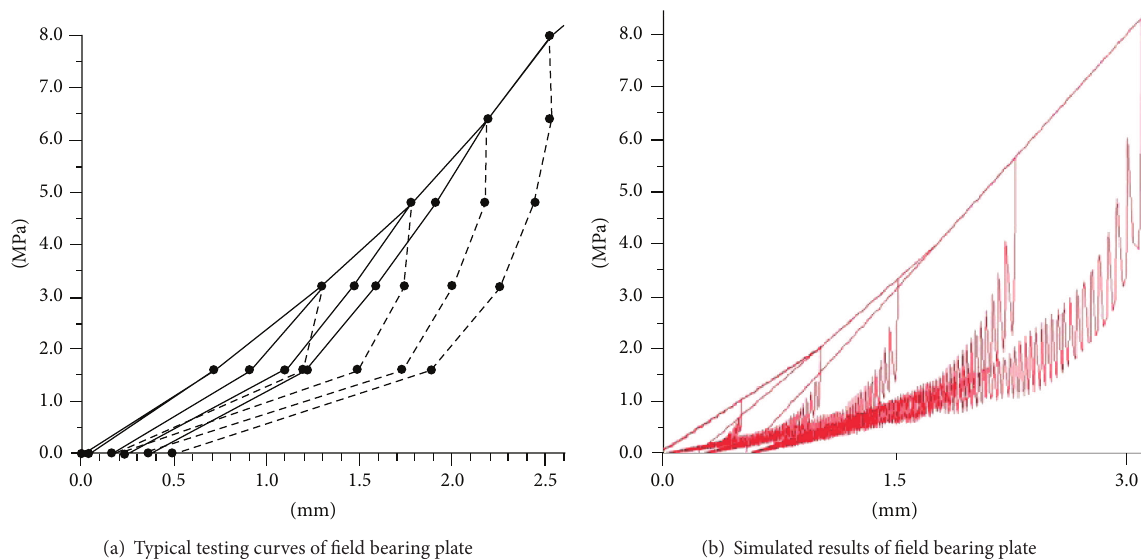
Figure 11: Contrast between field test and calculated